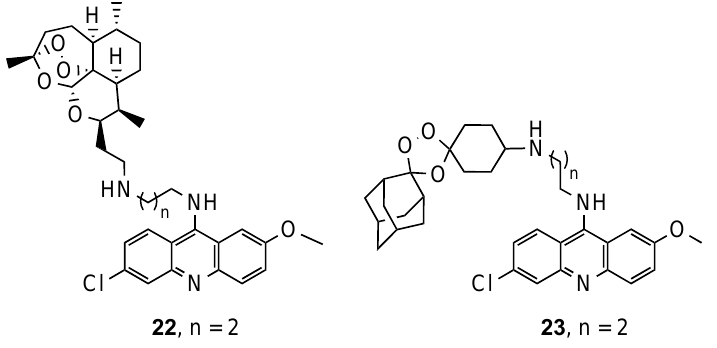
Figure 15. Synthetic and semi-synthetic artemisinin derivatives 22 and 23 developed by Araújo and co-workers [32].